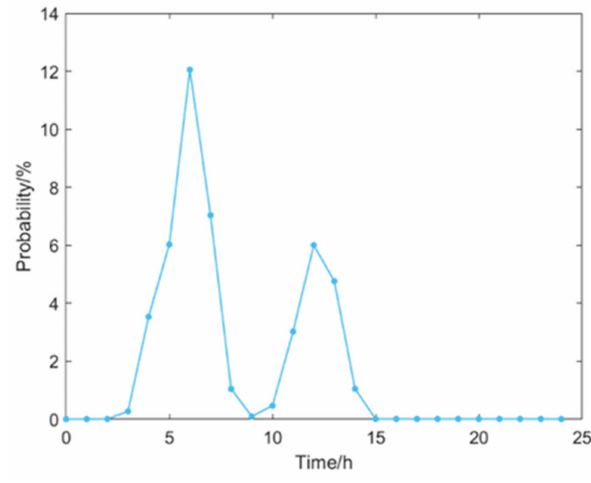
Figure 5. Probability distribution of travel